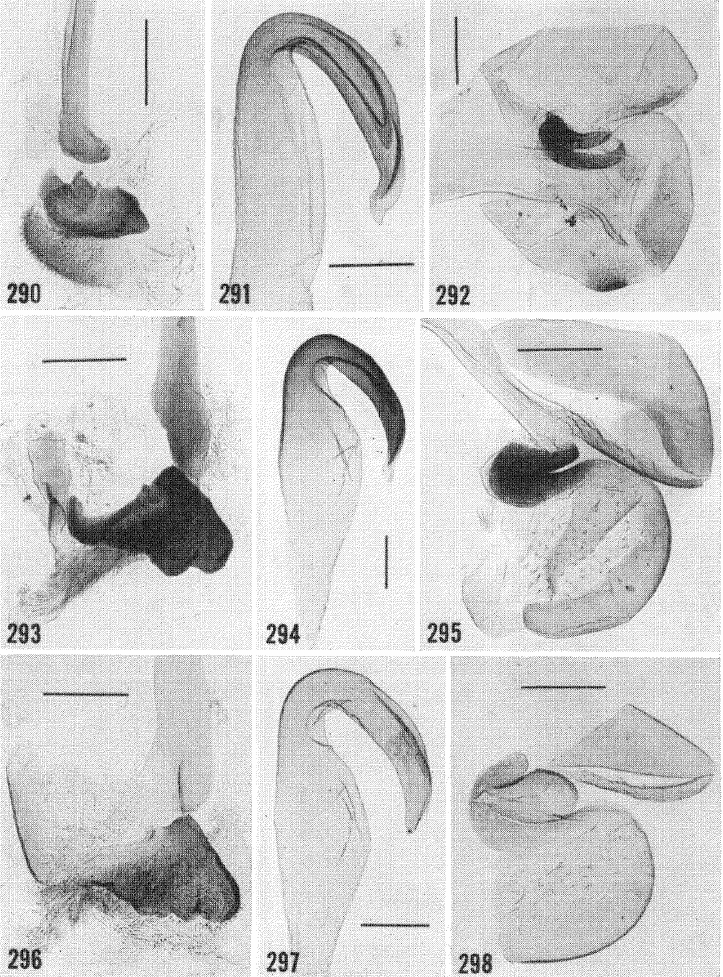
Figs. 290-298. Cockroach male genitalia. 290-292. (178 USNM). Epi- lampra azteca. Holotype of E. colorata R. S. Albuquerque and Gurney. Rio Felicio, Amapfi, Brazil. 293-298. Ep lampra corssea. 293-295. (40 ANSP). St. Jean du Maroni, French Guiana (det. Hebard). 296-298. (85 ANSP). Parfi, Brazil. (scale 0.2